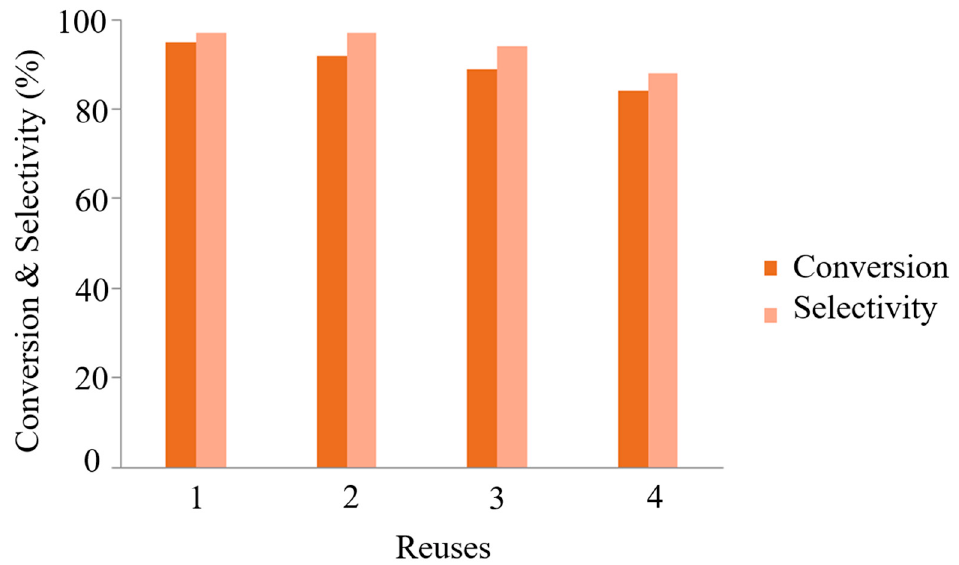
Figure 5. Recycle runs of γ -Fe 2 O 3 / SiO 2 -STZ in the oxidation of benzyl alcohol. Reaction conditions (each run): benzyl alcohol (1 mmol), H 2 O 2 (0.2 mL), catalyst (25 mg), 80 °C, 2 h.